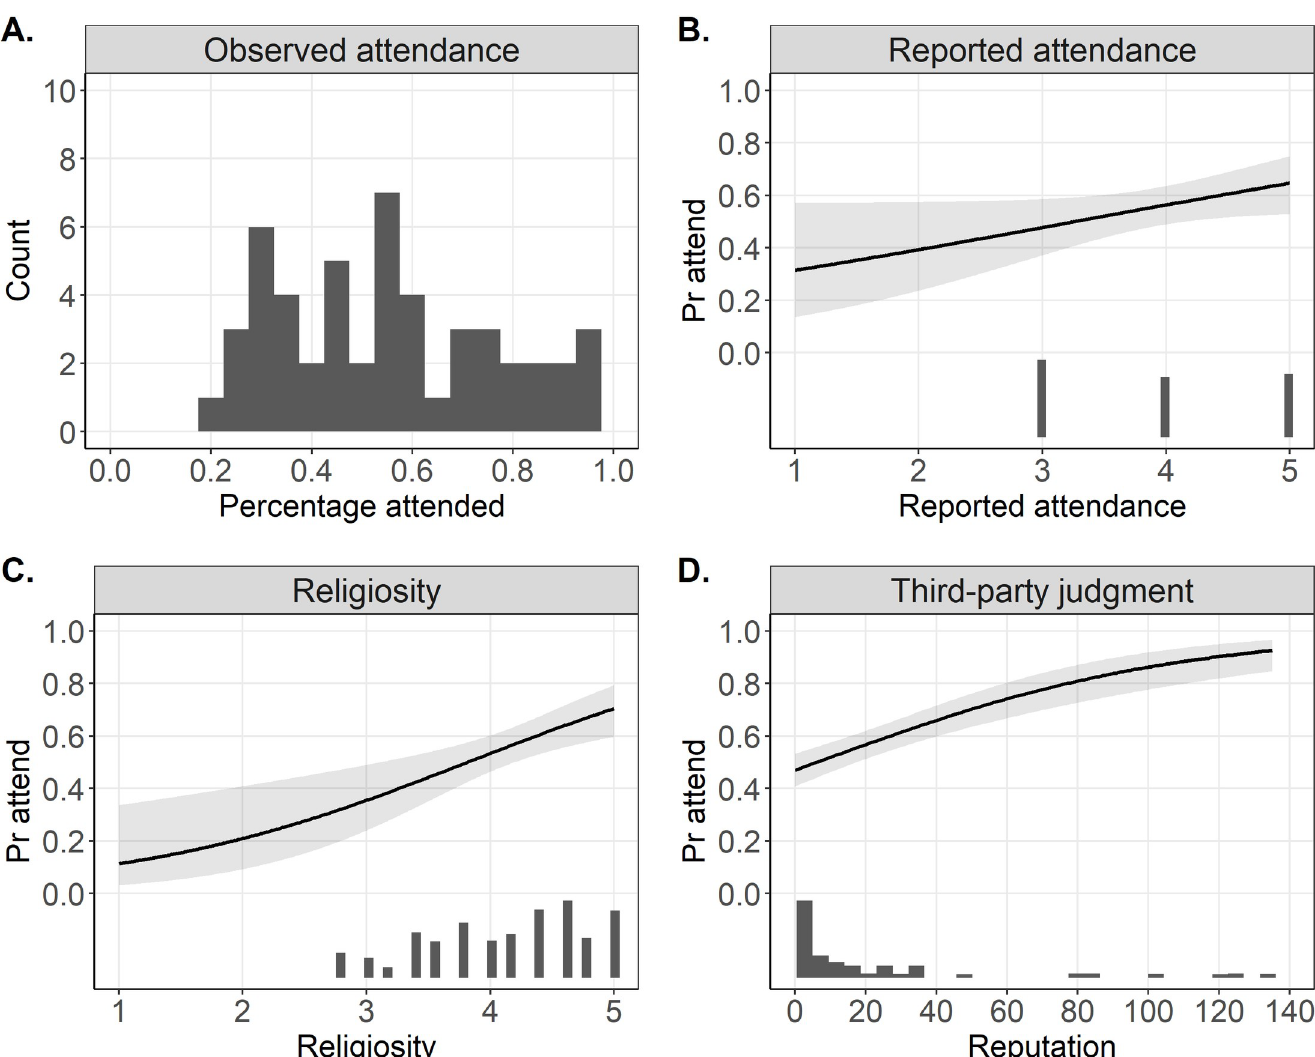
Fig 1. Observed attendance and its predictors. A–D report logit regression estimates with 95% CIs and underlying histograms of predictors. A. Histogram of percentage of attended events when at risk. B. Self-reported attendance was only weakly associated with observed attendance, partially due to the low variability of this scale. C. Likewise, religiosity revealed low variability, albeit its association with observed attendance was stronger than self-reported attendance. D. Third-party judgements of attendance was the strongest predictor of observed attendance, as supported by the semi-partial R 2 measure (R 2 β � j ).